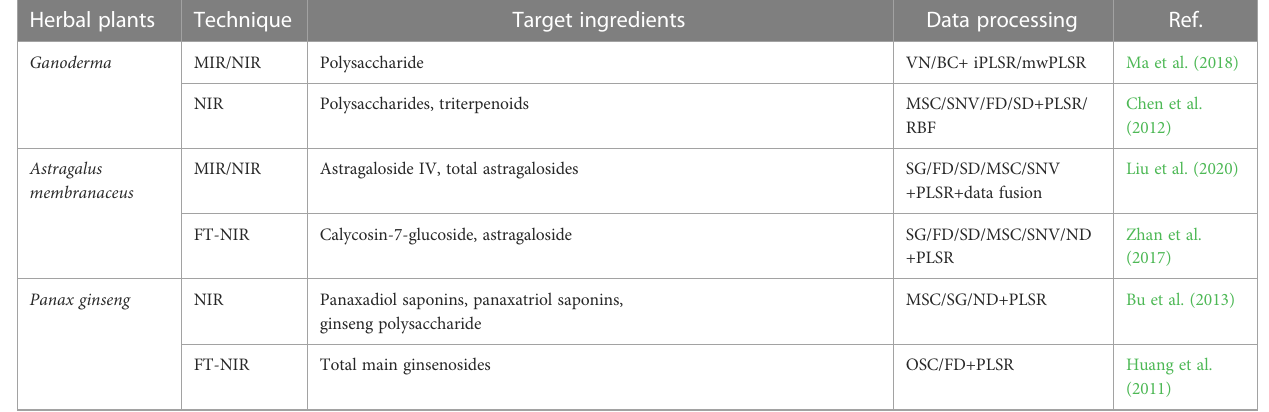
TABLE 4 Summary of quantitative analyses of herbal raw materials based on IR and Raman spectroscopy. Herbal